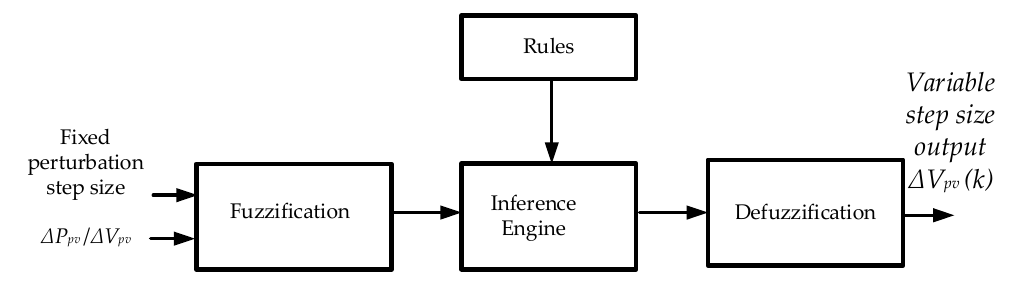
Figure 3. Fuzzy logic controller block diagram.